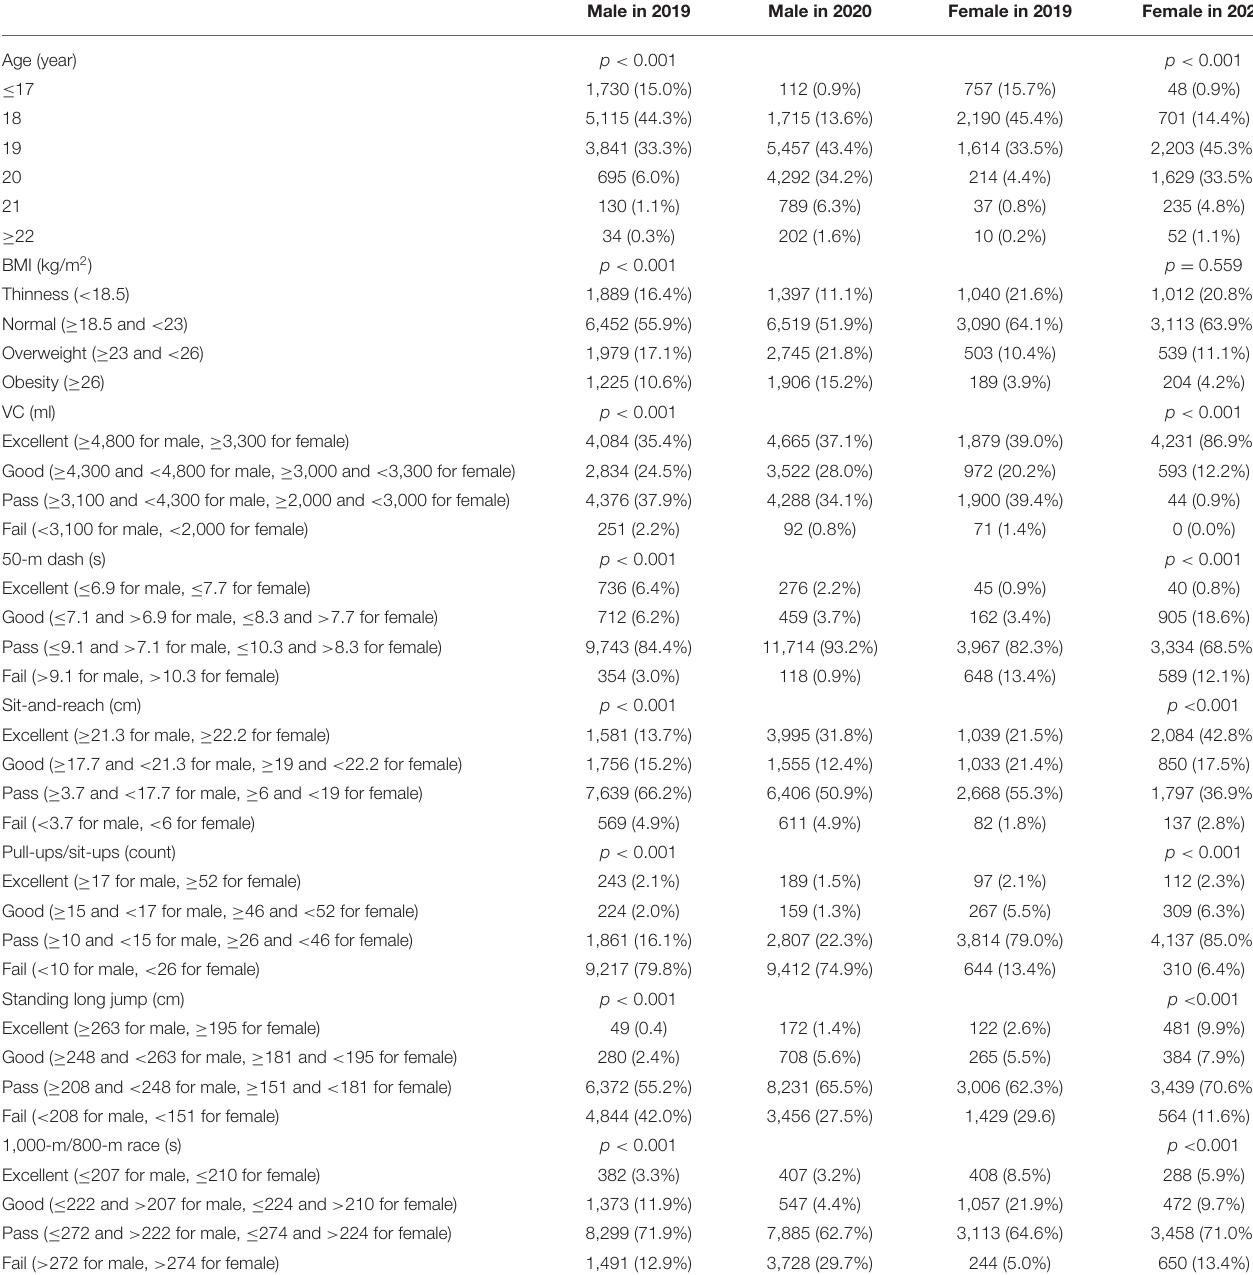
TABLE 1 | Classification evaluation of physical fitness tests from 24,112 male and 9,690 female